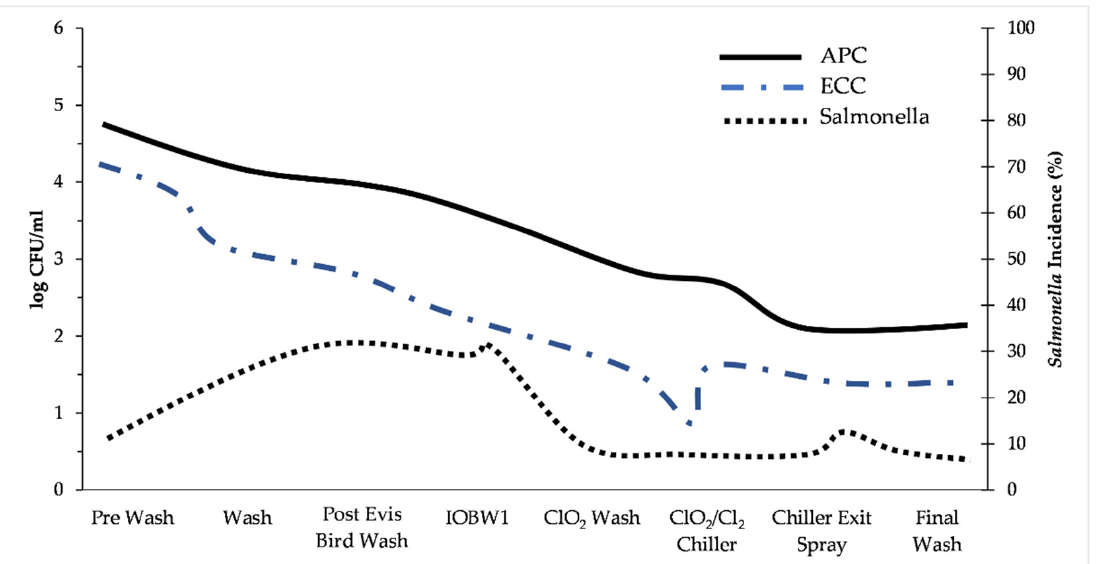
Figure 8. Microbial populations (log CFU per milliliter, mean SD) and Salmonella incidence (%) of carcasses following multiple interventions applied in sequence along the evisceration (slaughter) line at a poultry plant. The first point represents the stage before the first intervention, and every point thereafter represents the populations after the specific intervention. Post-Evis, post-evisceration wash; IOBW1, inside-outside bird wash 1ClO 2 , chlorine dioxide wash; ClO 2 -Cl 2 , chlorine dioxide wash plus chlorine chiller. Redrawn from Stopforth et al. [59].